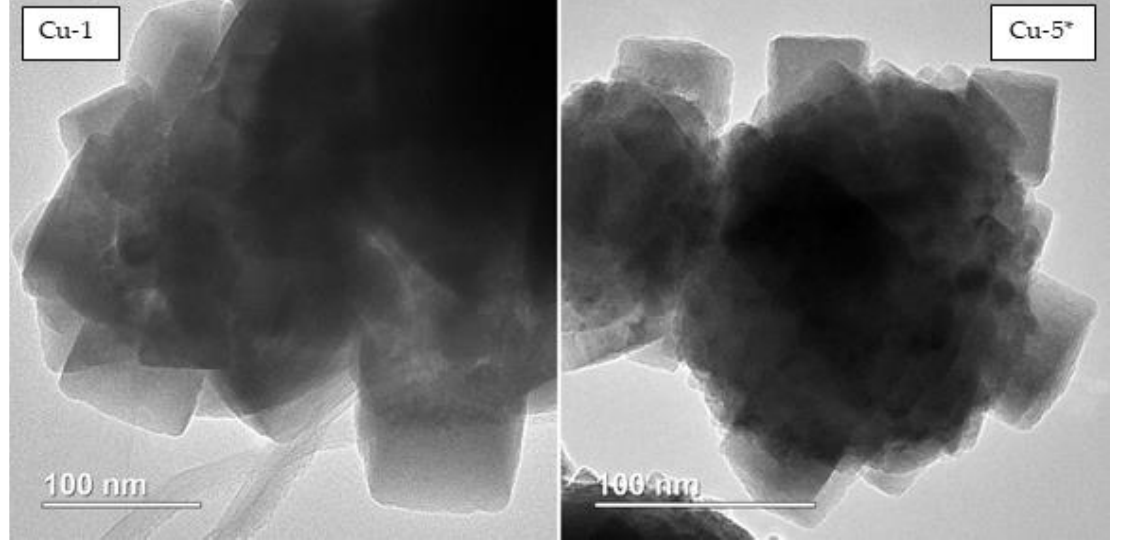
Figure 10. The HRTEM microphotographs of the copper catalysts (Cu-1, Cu-5*) generated in situ in the reaction medium during hydrogenolysis of glycerol.